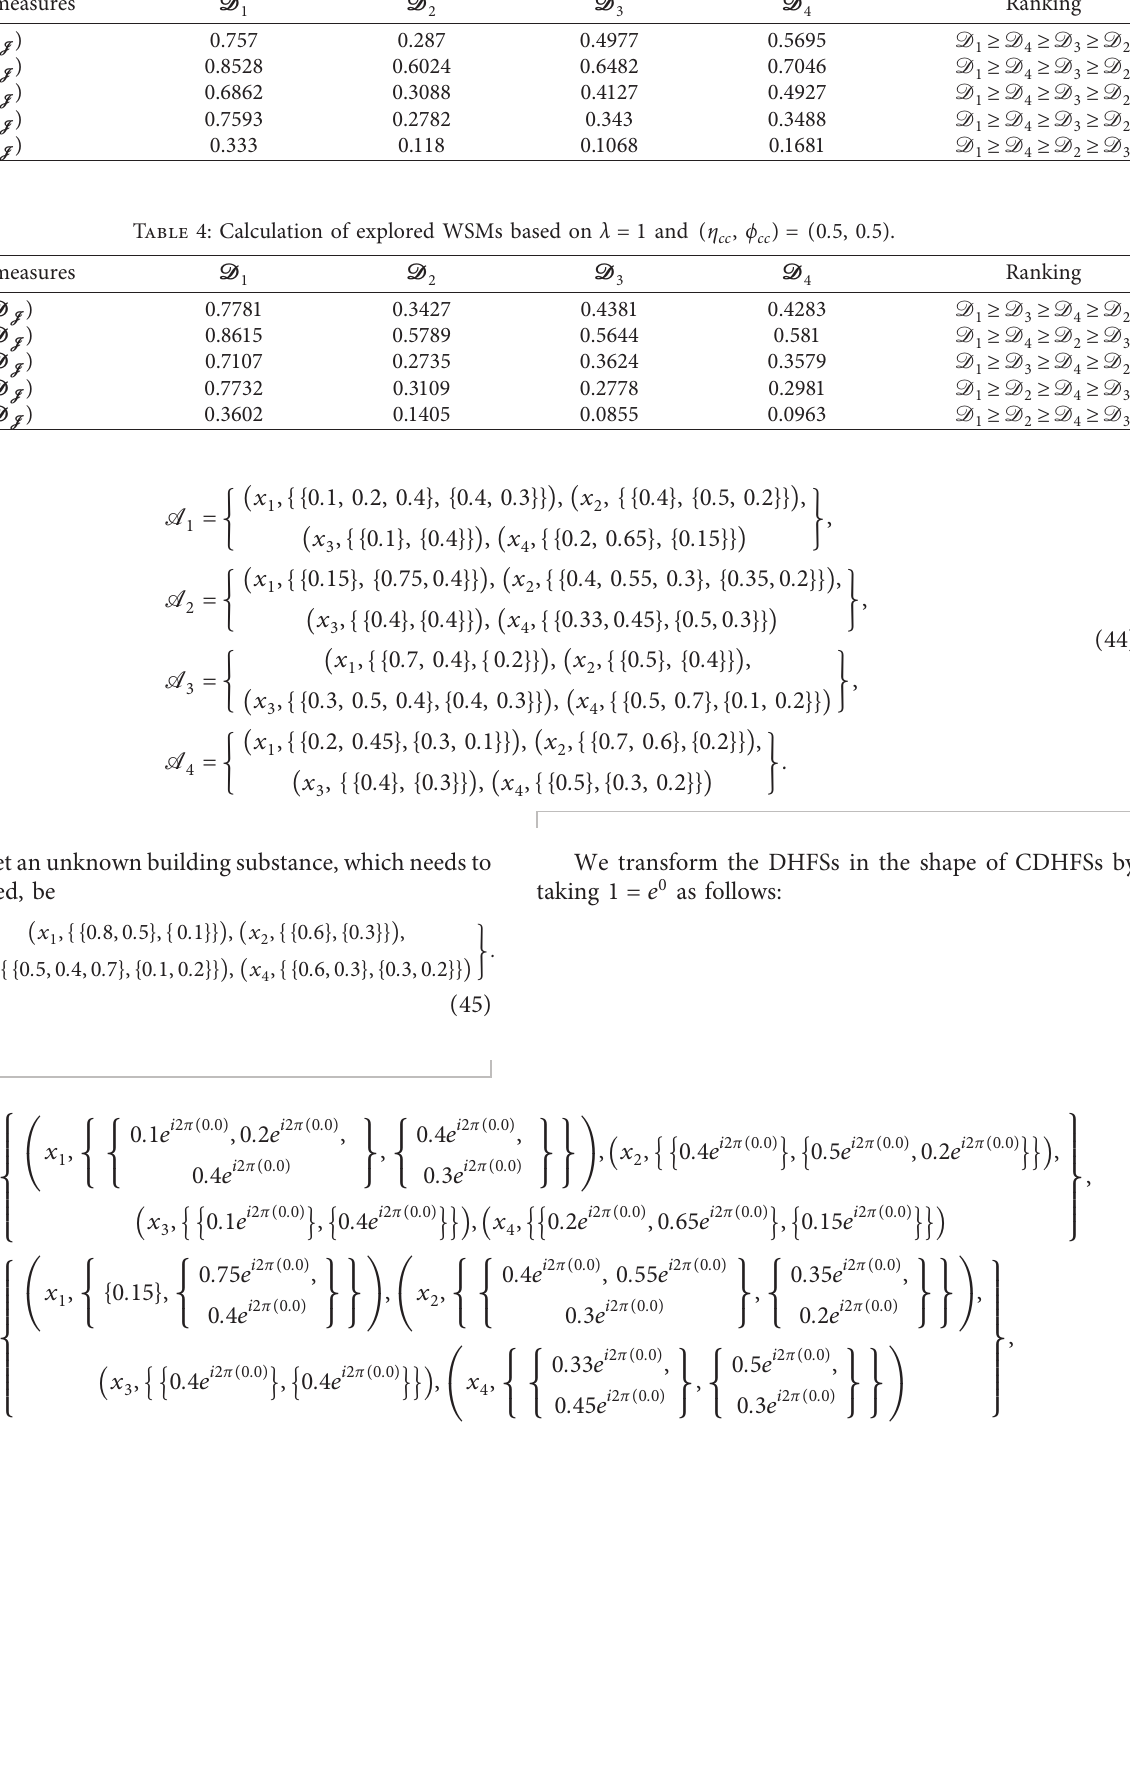
Table 3: Calculation of explored SMs based on λ � 1 and ( η